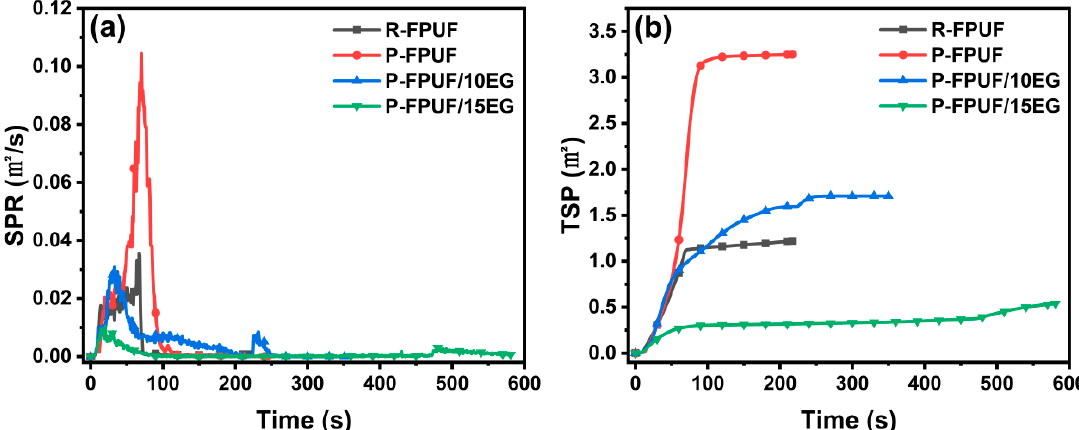
Figure 6. Smoke production rate ( a ) and total smoke production ( b ) for FPUFs.